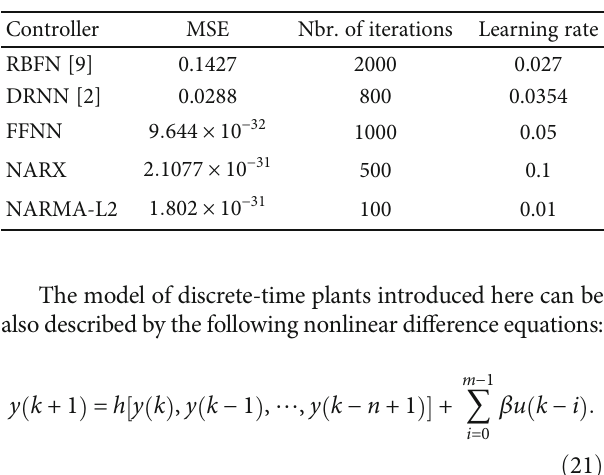
Figure 12: Reference model and open-loop response of the plant without a controller (example 3). Table 3: Comparison of the performance index of the proposed controller and other controllers (example